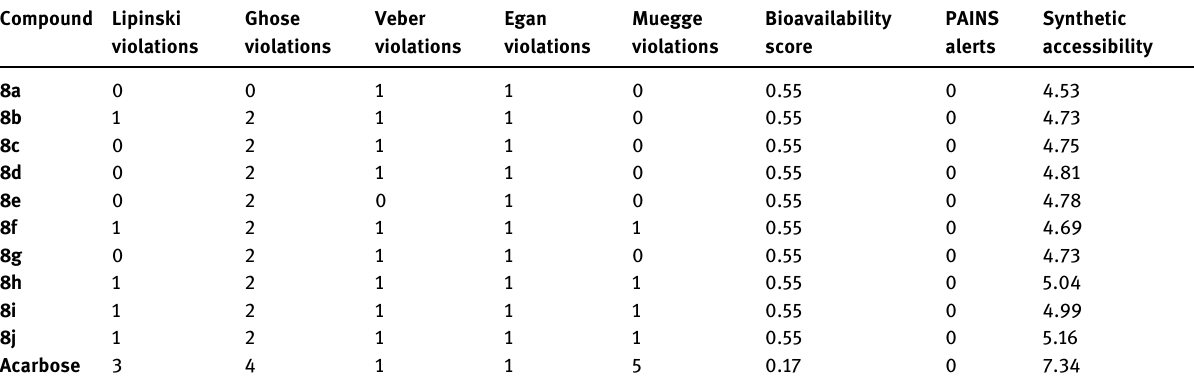
Table 7: Drug likeness properties of compounds 8a – j Compound